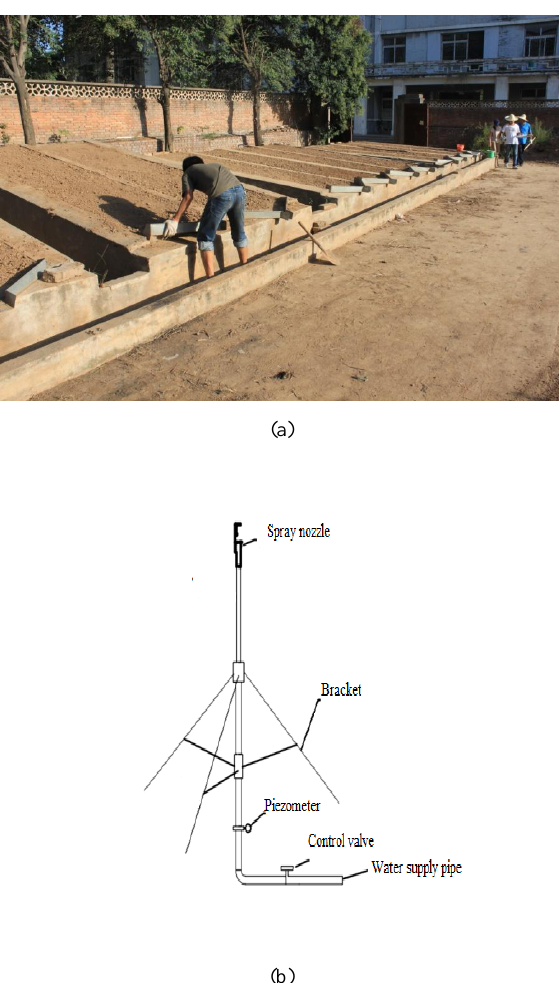
Figure 1. Experimental runoff plots (a) and schematic of the rainfall simulator (b)